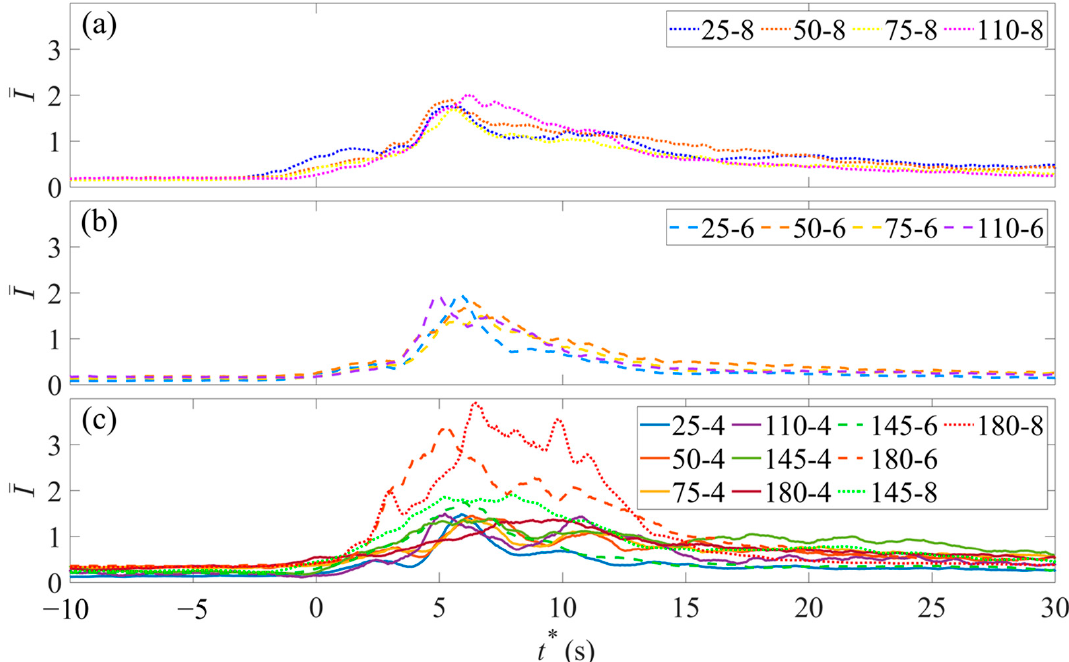
Figure 11. Temporal variations in average turbulence intensity: ( a ) complete hydraulic jump condi- tion, ( b ) wavy hydraulic jump condition and ( c ) no hydraulic jump condition.